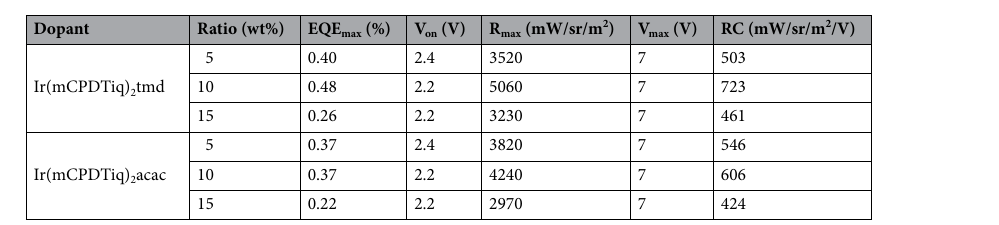
Figure 5. Electrical and optical properties of the NIR OLEDs. ( a ) Energy level alignment diagram and molecular structure ( b ) EL spectra by concentration ( c ) J–V–R ( d ) EQE of the NIR OLEDs depending on the doping concentrations.